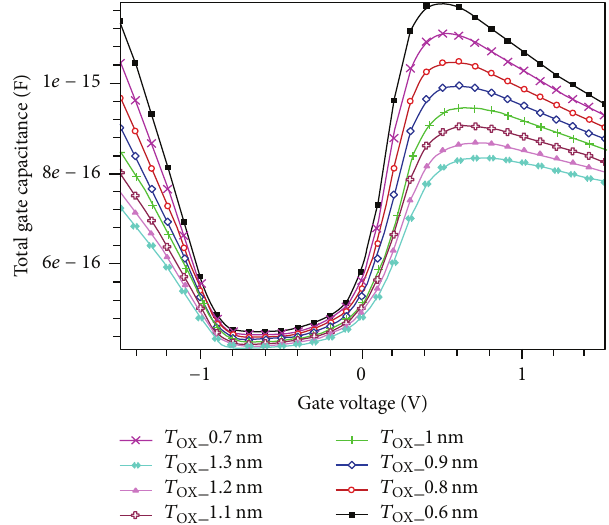
Figure 5: Gate capacitance as a function of 𝑉 GS for 45nm